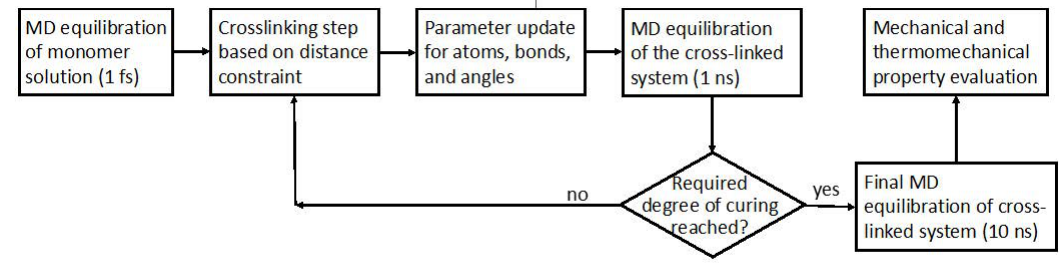
Figure 3. Flow diagram for the molecular dynamics and crosslinking simulation procedure.